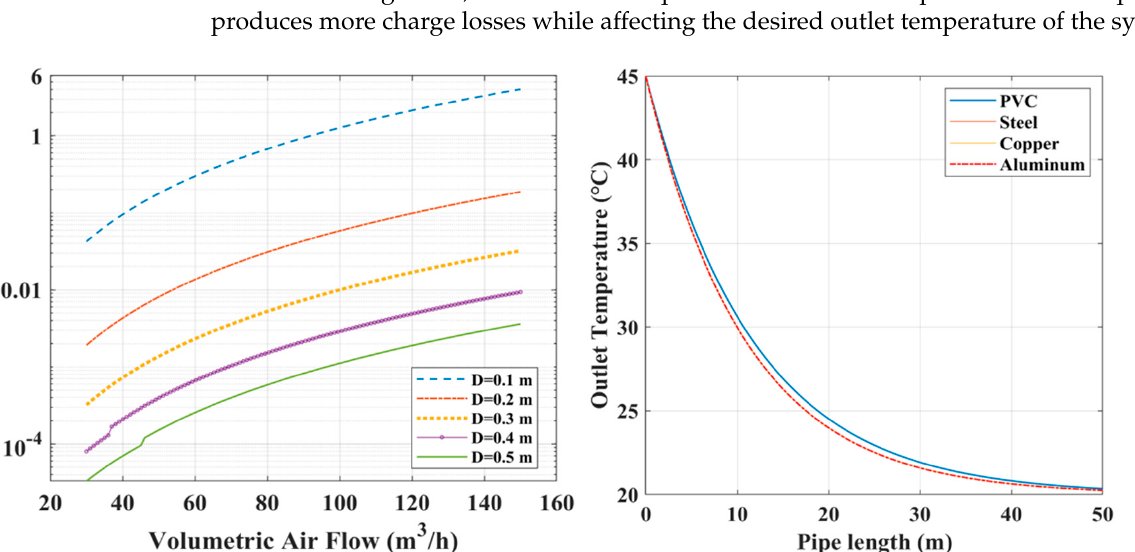
Figure 13. The outlet temperatures of the EAHE system as a function of different pipe lengths and diameters. The difference in temperature between the pipe diameters varied between 1.5 and 2 °C for a 17 m pipe length. For the winter period, where the EAHE works as a heater, it is shown that the system helps to increase the inlet temperature from 5 to 20 °C with a dif- ference of 15 °C for a pipe diameter of 0.1 m. The temperatures outlets for the different pipe diameters remain in the same interval as the summer period. The results of this study highlight the required parameters, such as the appropriate diameter of PVC pipe as well as the required length, air flow and ventilation power. We